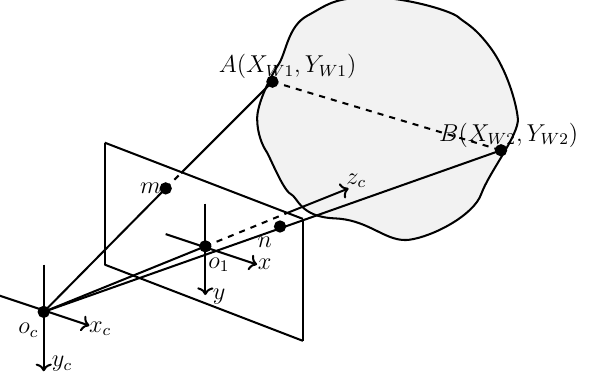
Figure 8. Wood contour in the